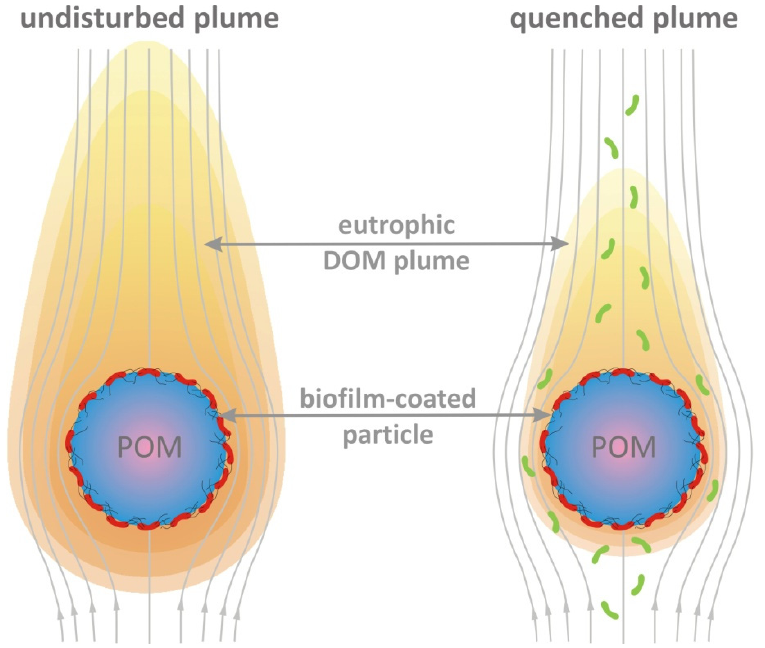
Figure 1. Conceptual illustration of nutrient plume quenching. The sinking particle (POM) creates a comet-shaped eutrophic plume of dissolved organic matter (DOM) with products from the enzymatic hydrolysis of particulate ingredients and the metabolic activities of surface-attached bacteria (red). Free-living bacteria (green) may act as point sinks, harvest useful solutes and reshape the nutrient field around the particle. The reduction in the extent and intensity of the plume is referred to as plume quenching and affects microbial foraging processes in the oceans. The plume length is critical in the detection of the organic particle by zooplankton [35] and the volume of the plume supports elevated growth rates for bacterioplankton [36].